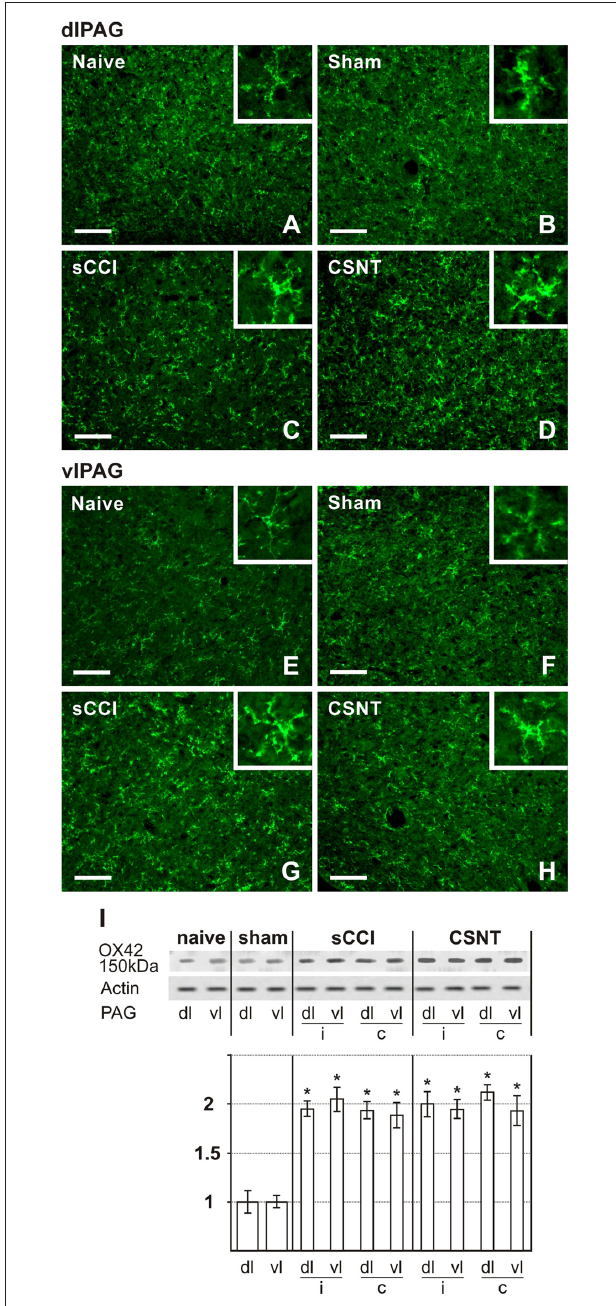
FIGURE 4 | Representative sections illustrating OX42 immunofluorescence staining in dlPAG (A–D) and vlPAG (E–H) of naïve, sham-, sCCI- and CSNT-operated rats. Insets show the typical morphological types of OX42+ microglial cells from the respective animal groups. Scale bars = 90 µ m. (I) Western blot analysis of OX42 (CD11b/c) protein. The top panel illustrates representative western blot in PAG of naïve and sham-operated rats and rats 3 weeks after sCCI or CSNT. (i) indicates ipsilateral and (c) contralateral segments of dorsolateral (dl) and ventrolateral (vl) PAG. Graph below the blot illustrates density data obtained from three blots after normalization to actin, expressed as fold-change relative to those of sham-operated rats (set as 1). ∗ Indicates a statistically significant difference ( p < 0.05) compared to the value from sham-operated